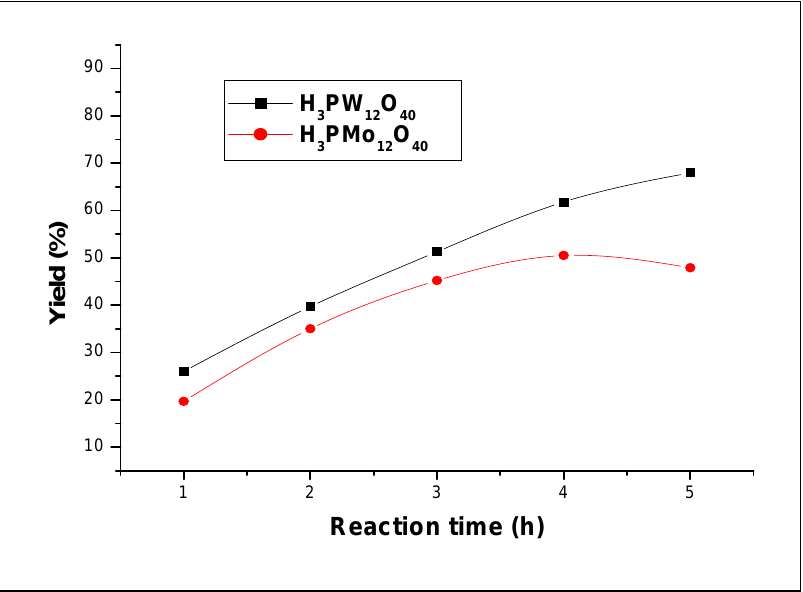
Figure 5. Effect of the reaction time on the styrene polymerization (in dichloromethane) over H PW O and H PMo O catalysts. Polymerization was carried out at 25 ºC using 3 12 40 3 12 40 10 mg of catalyst.